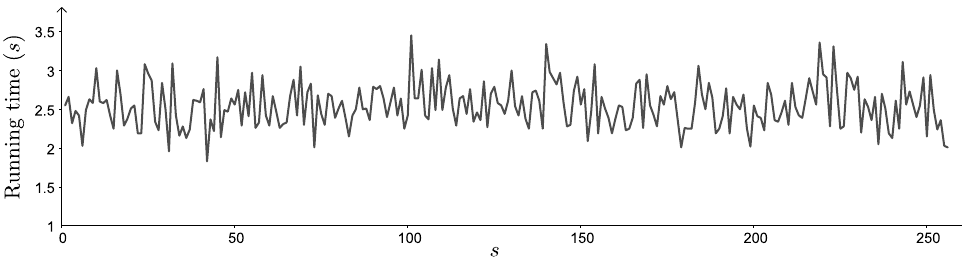
Figure 6. Running time (in seconds) required for computing the cardinality of the set V C ( I ( P ( L ))) , with 1 ≤ s ≤ 256, and L being the Latin square described in Figure 90,90; s